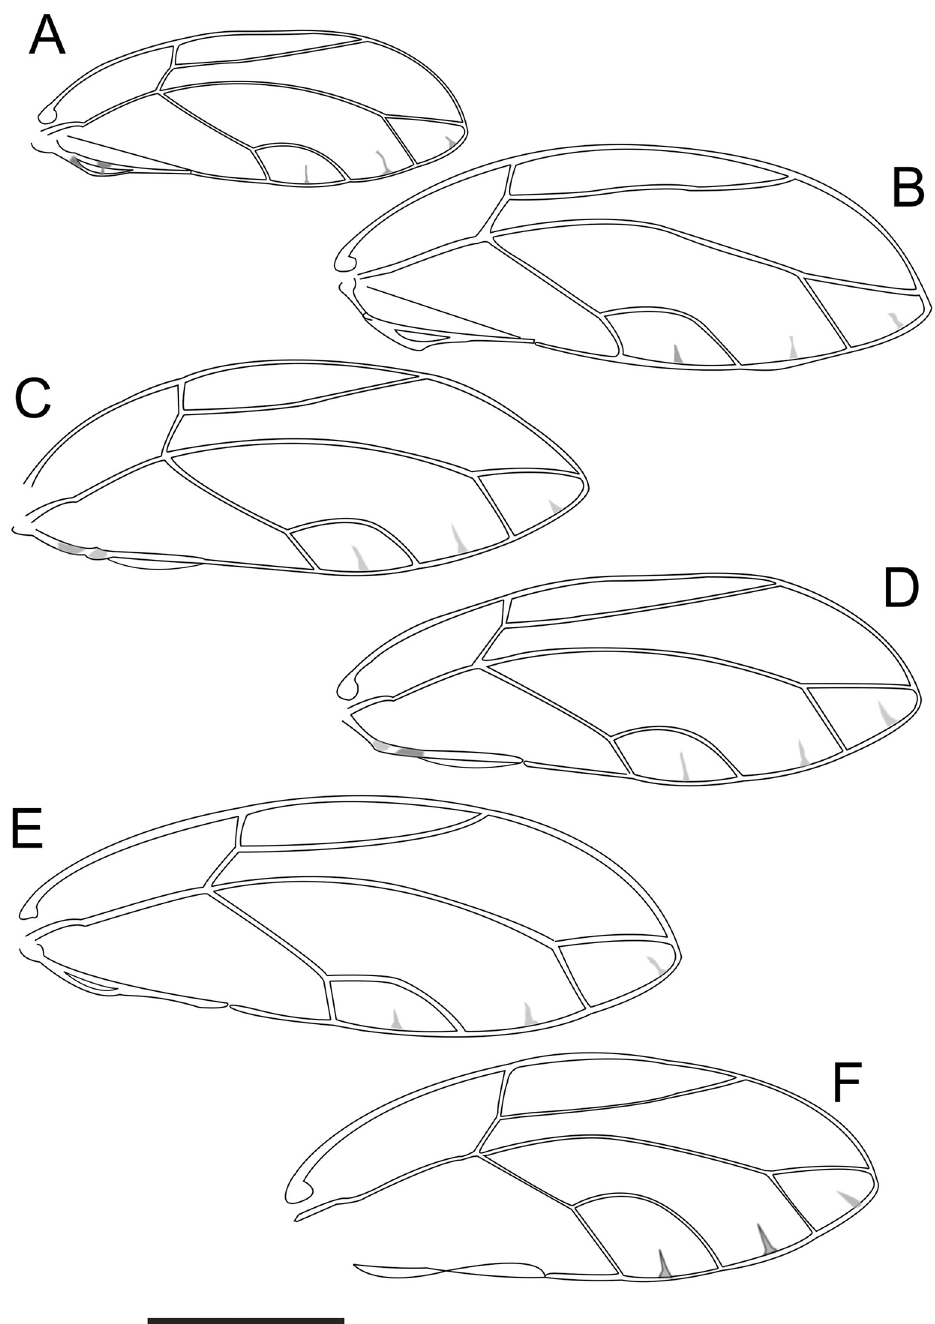
Fig 4. Female wings of Trioza melaleucae ( A ), T . curta ( B ), T . adventicia ( C ), T . eugeniae ( D ), T . erytreae ( E ) and T . tristaniae ( F ). Scale bar is 1